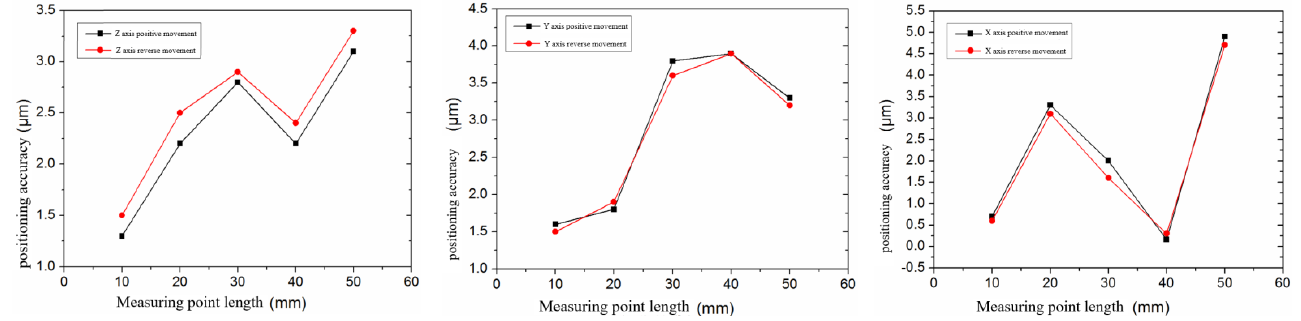
Figure 20. Motion accuracy of each axis.